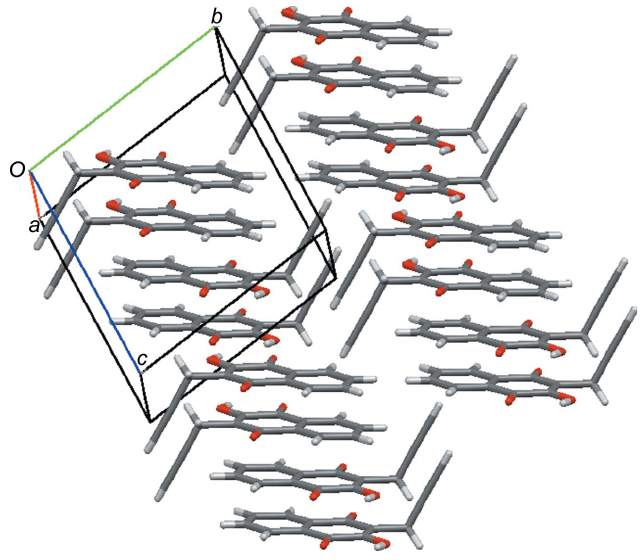
Figure 2 A packing diagram of the title compound.